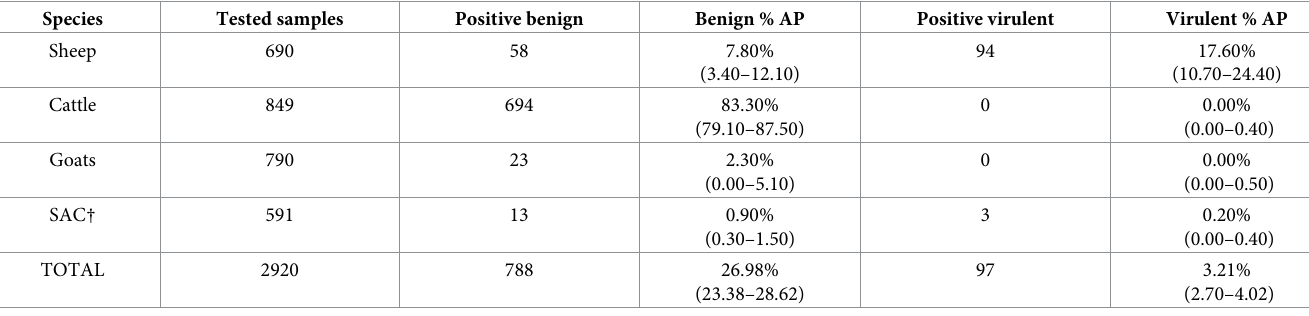
(all adult males). The estimated apparent prevalence for the benign and virulent strains by spe- cies is given in Table 1 (wild animals) and Table 2 (domestic animals for comparison). Due to the low prevalence of D . nodosus per species, the true prevalence (TP) could only be calculated for red deer (TP = 6.08%, CI = 3.5–9.3). 95% All positive samples originated from animals from six out of 26 Swiss cantons (S1 Table), all of them located in subalpine to alpine zones ( > 1000 m above sea level) except for five red deer and one roe deer from the mountain and foothill zones. The majority (N = 27, 68%) of the pos- itive animals originated from the canton of Grisons (23 red deer with benign strains; and two ibex: one positive for benign and the other one for virulent strains). Positive samples were found in both sampling years (14 in 2017; 23 in 2018). Most animals positive for benign D . nodosus (78%, N = 28) were reported to be in good body condition and a few animals were reported to be in moderate (19%, N = 7) and poor (3%, N = 1) body condition. The single ibex positive with the virulent strain was in a moderate body condition. Foot lesions. Four of the 31 (12.9%) red deer positive for benign strains of D . nodosus were reported by the sample submitters as having foot lesions. Two of them were reported to Table 2. Prevalence of D . nodosus in Swiss domestic ungulates for comparison.